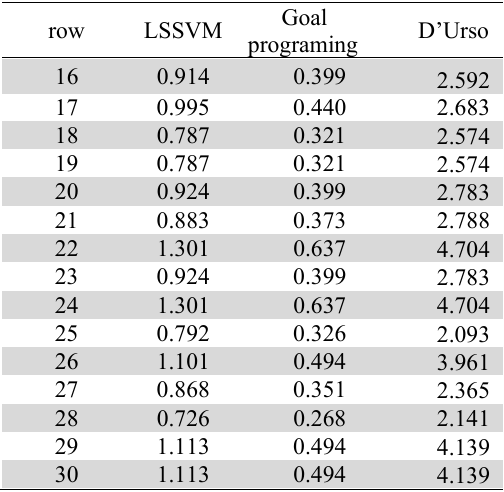
Result of the case study for methods